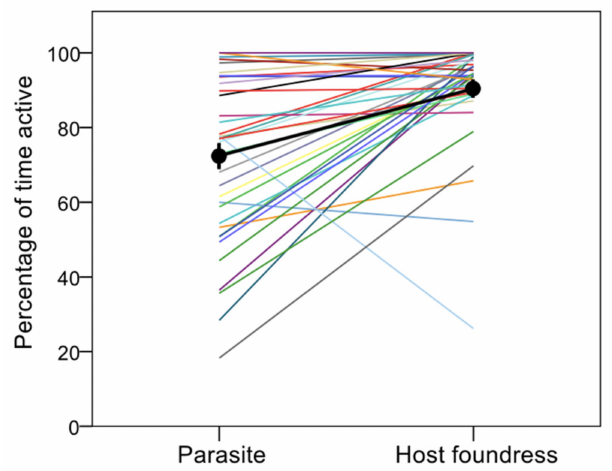
Figure 2. Percentage of time parasites and hosts were active (vs resting) during the observation session. Each line links the values for the parasite (left) and her host foundress (right) living at the same colony (pairwise data); the black thick line links the mean values ( ± s.e.) for parasites and foundresses (after averaging by colony). Variation as a function of time of the day is not shown. Parasites spent a larger proportion of time at the nest than their host foundresses (GLMM, [parasite]: β = 3.815 ± 0.850, χ 2 = 20.148, df = 1, p < 0.0001) (Figure 3).